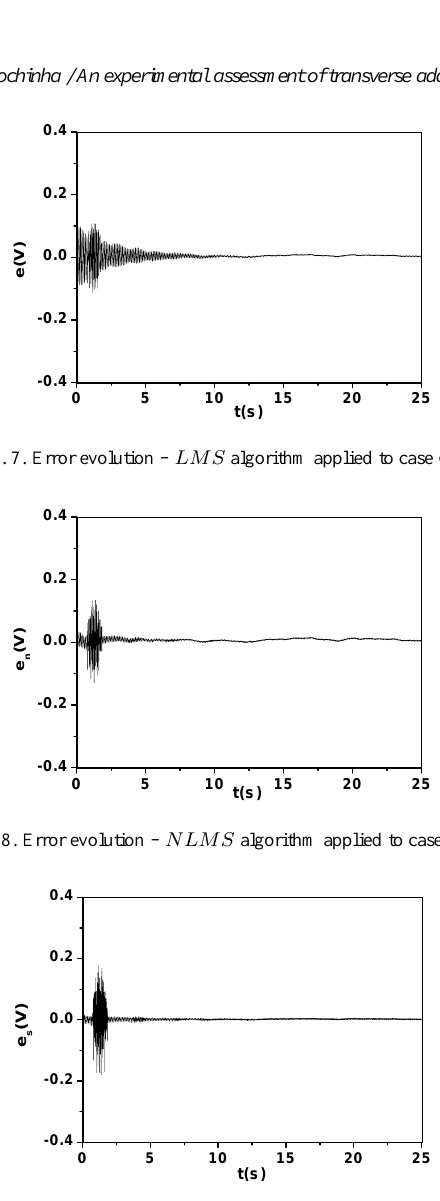
Fig. 9. Error evolution – SM − BNDRLMS algorithm applied to case C 2